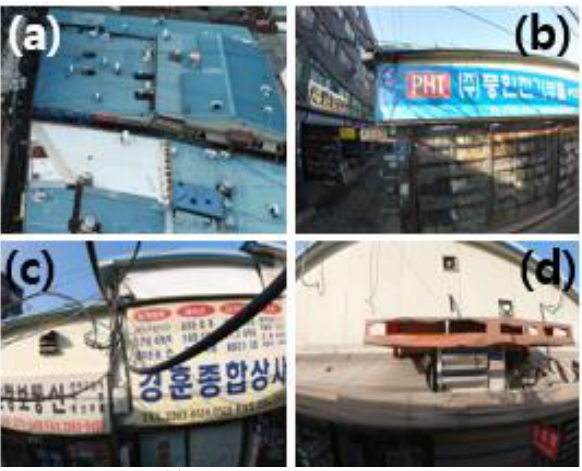
Figure 8. Picture (a) is one of images taken by the drone flying west to east. Others were taken with the action camera.